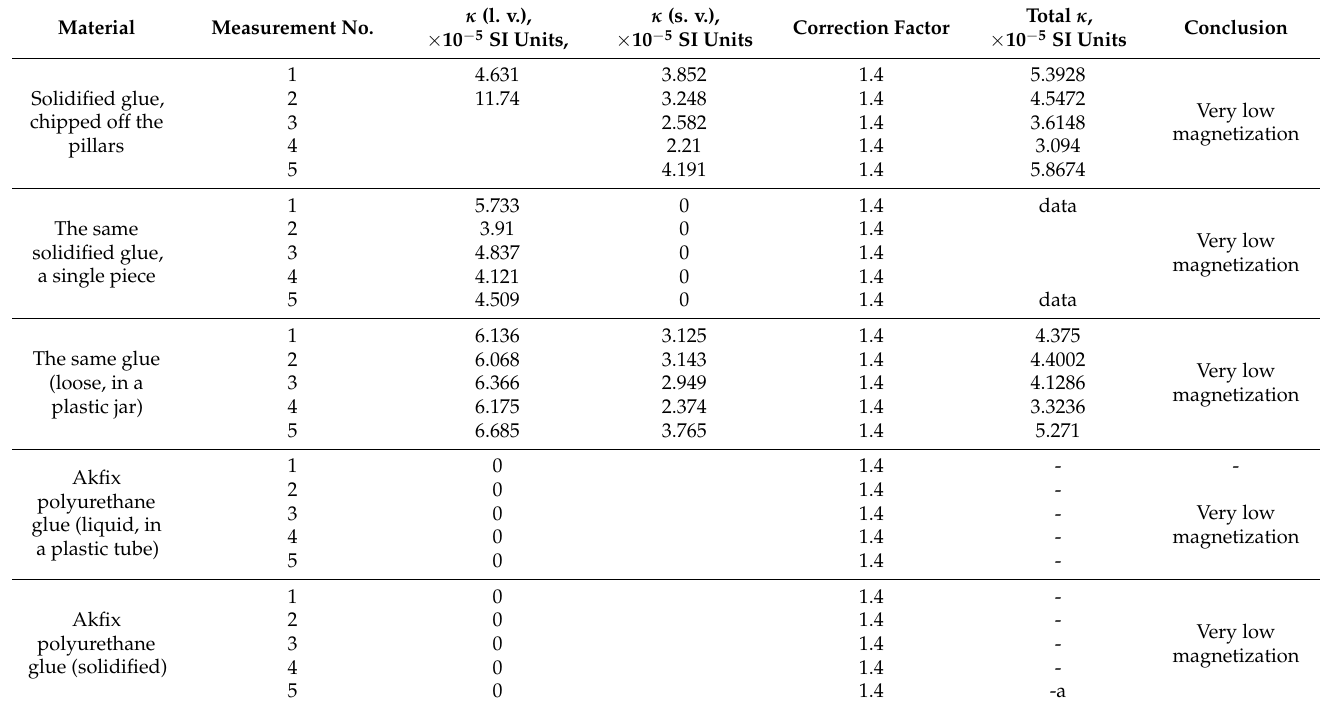
Table 5. Magnetic susceptibility of glue used for construction of pavilions and pillars at the Gyula- garak